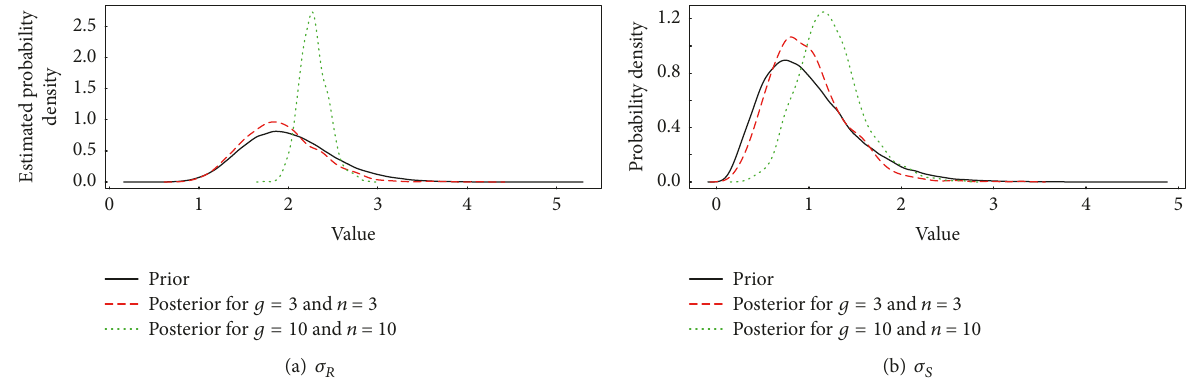
Figure 4: Prior and posterior probability densities for data from realization of (8) for 𝜎 𝑅𝐼 and 𝜎 𝑆𝐼 for 𝑔 = 3 and 𝑛 = 3 and for 𝑔 = 10 and 𝑛 = 10 . The true values are 𝜎 𝜎 𝑅𝐼 = 2.3 (% relative) and 𝑆𝐼 = 1.2 (%